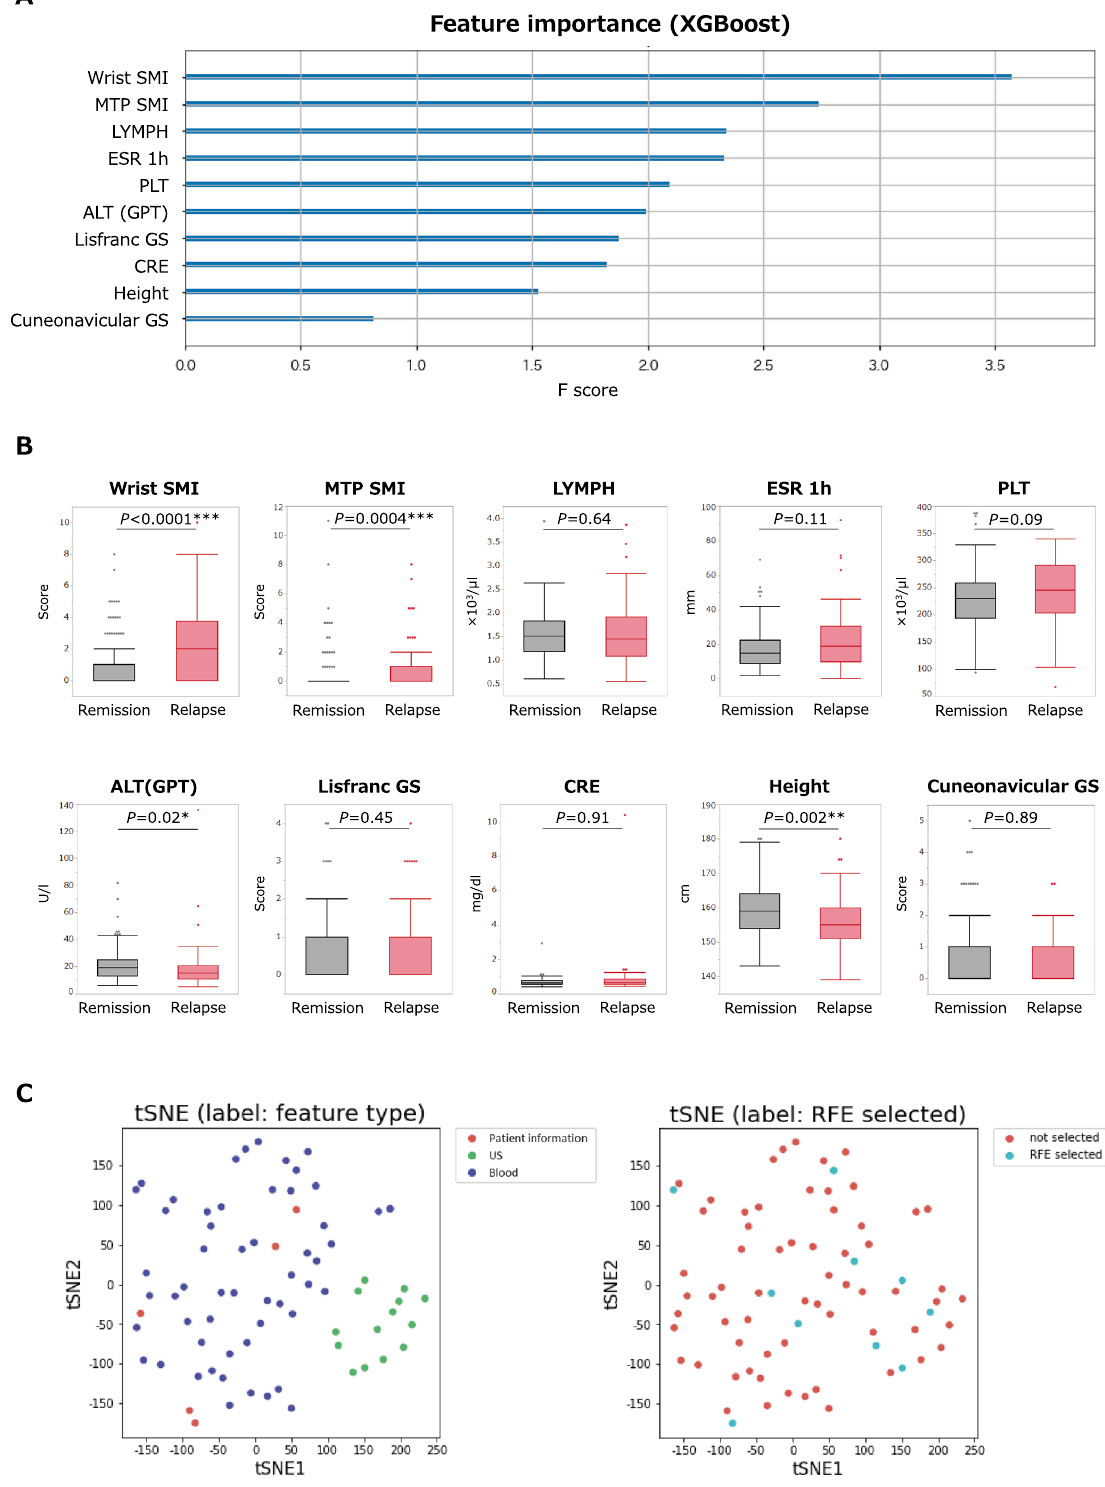
Figure 3. Feature importance for predicting relapse and comparison of each feature between RA patients with remission and relapse. ( A ) Importance of features for predicting relapse calculated by XGBoost model. ( B ) Comparison of each feature between RA patients with remission and relapse. ( C ) Visualization of the characteristics of the selected features in XGBoost model using tSNE. * P < 0.05, ** P < 0.01, *** P < 0.001. SMI superb microvascular imaging, MTP metatarsophalangeal, LYMPH lymphocyte count, ESR erythrocyte sedimentation rate, PLT platelet count, ALT alanine aminotransferase, GPT glutamic pyruvic transaminase, GS gray scale, CRE creatinine, US